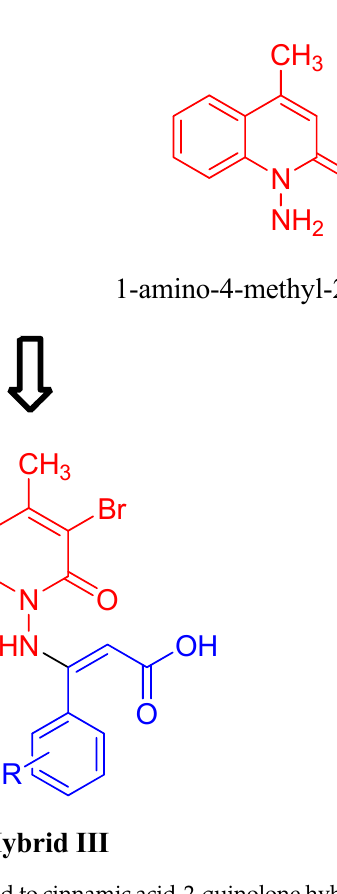
Figure 1. Molecular strategy related to cinnamic acid-2-quinolone hybrid III obtained from hybrid- ization of cinnamic acid ( I ) and 1-amino-4-methyl-2-quinolinone ( II ) . tion of cinnamic acid ( I ) and 1-amino-4-methyl-2-quinolinone ( II